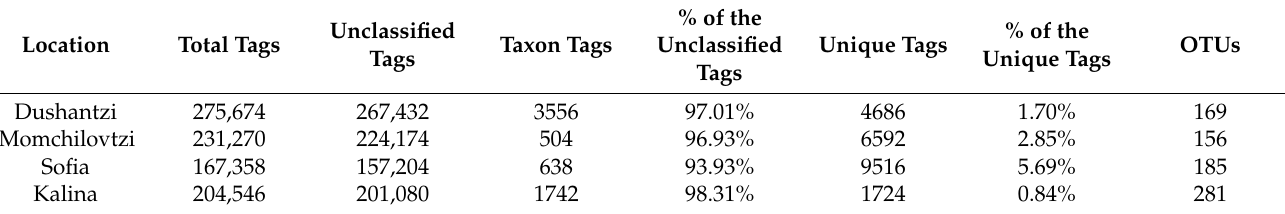
Table 2. Summarization of the annotation of the NGS